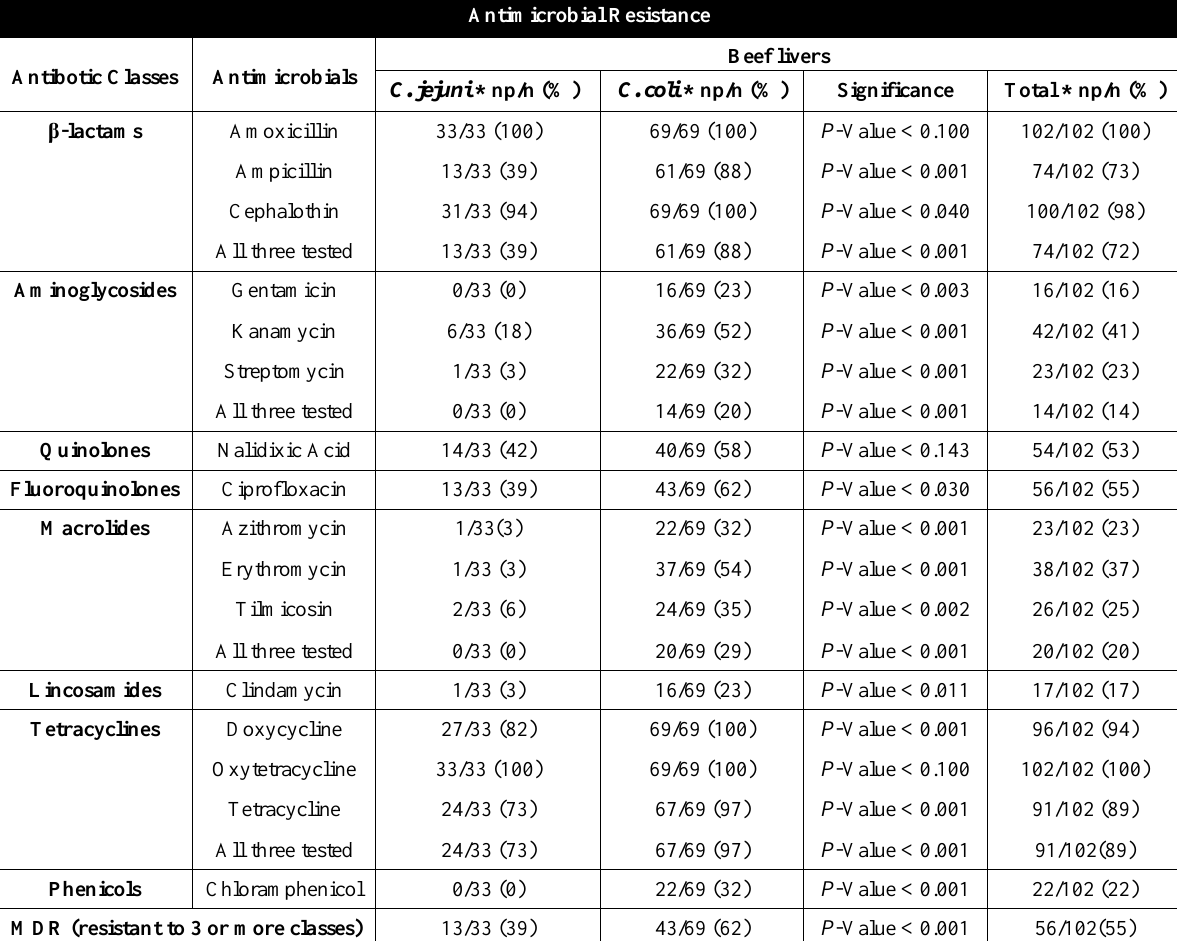
Table 3. Antimicrobial resistance of the 102 Campylobacter beef livers isolates against 8 different antibiotic